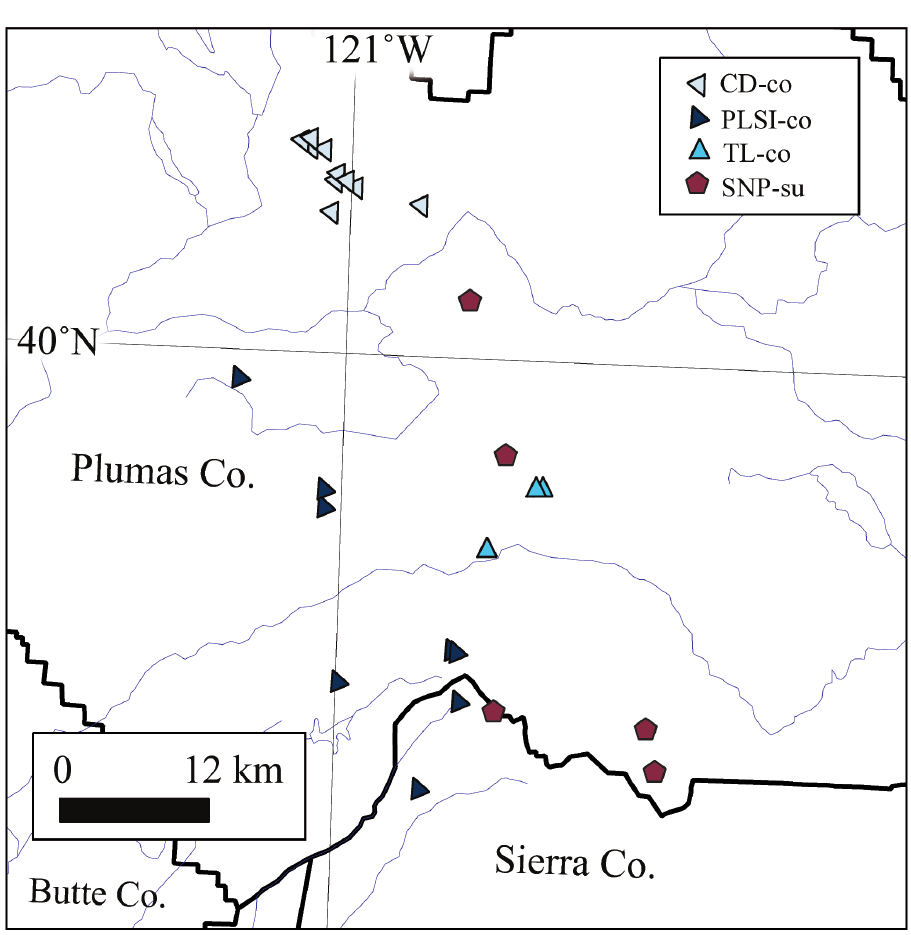
Figure 4. Distribution of diploid B. constancei s.l. and SNP-su clusters in Plumas County, California. CD-co lies to the north of the east branch of the north fork of the Feather River. The type locality cluster (TL-co) exhibited unstable placement in both genetic clustering